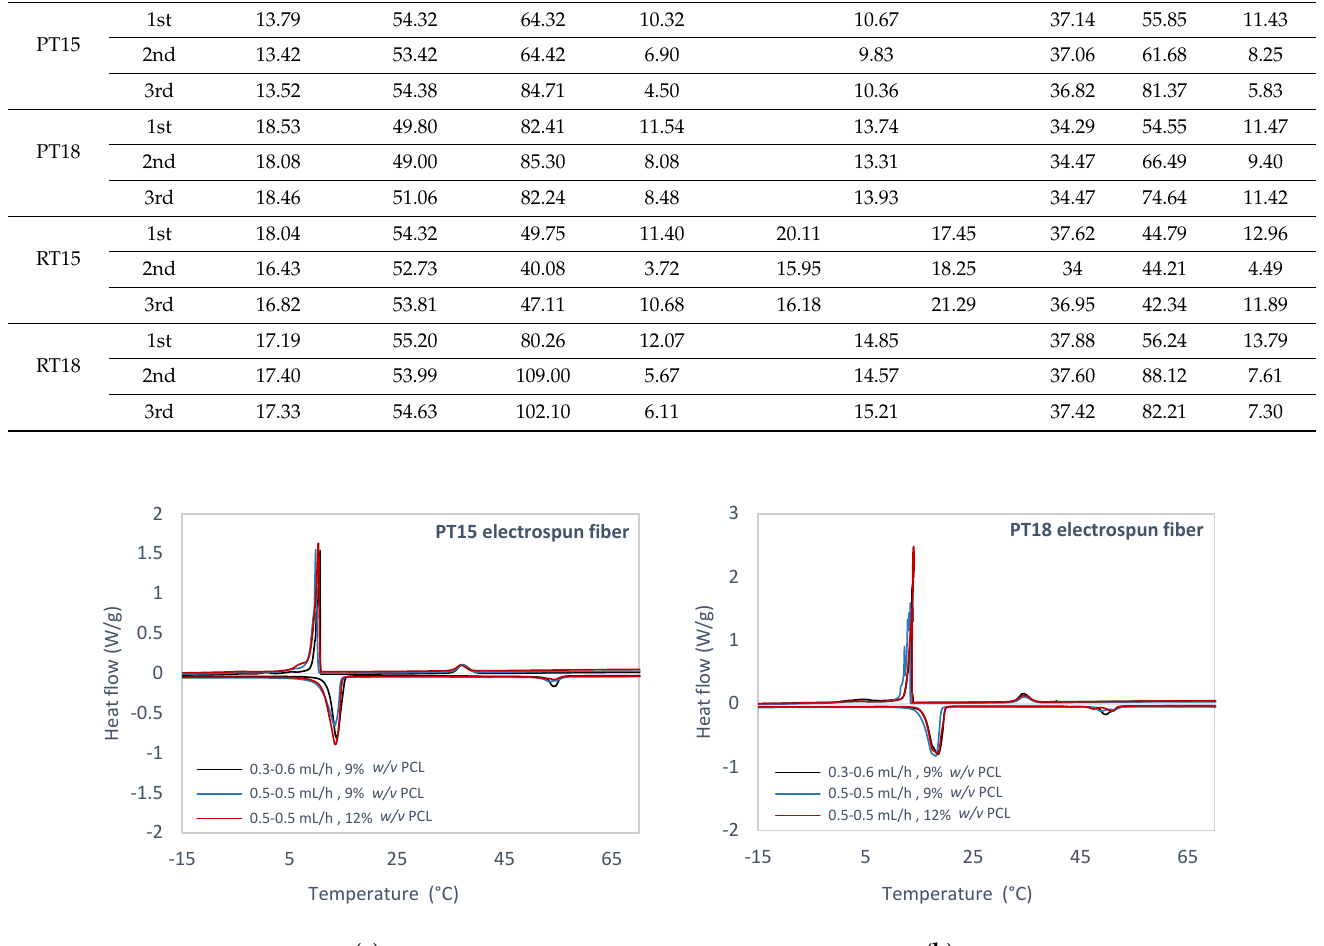
Figure 4. Optical microscopy images of ( a ) PT15, ( b ) PT18, ( c ) RT15 and ( d ) RT18 emulsions. Table 3. Average droplet size for PT15, PT18, RT15, and RT18 water emulsions.